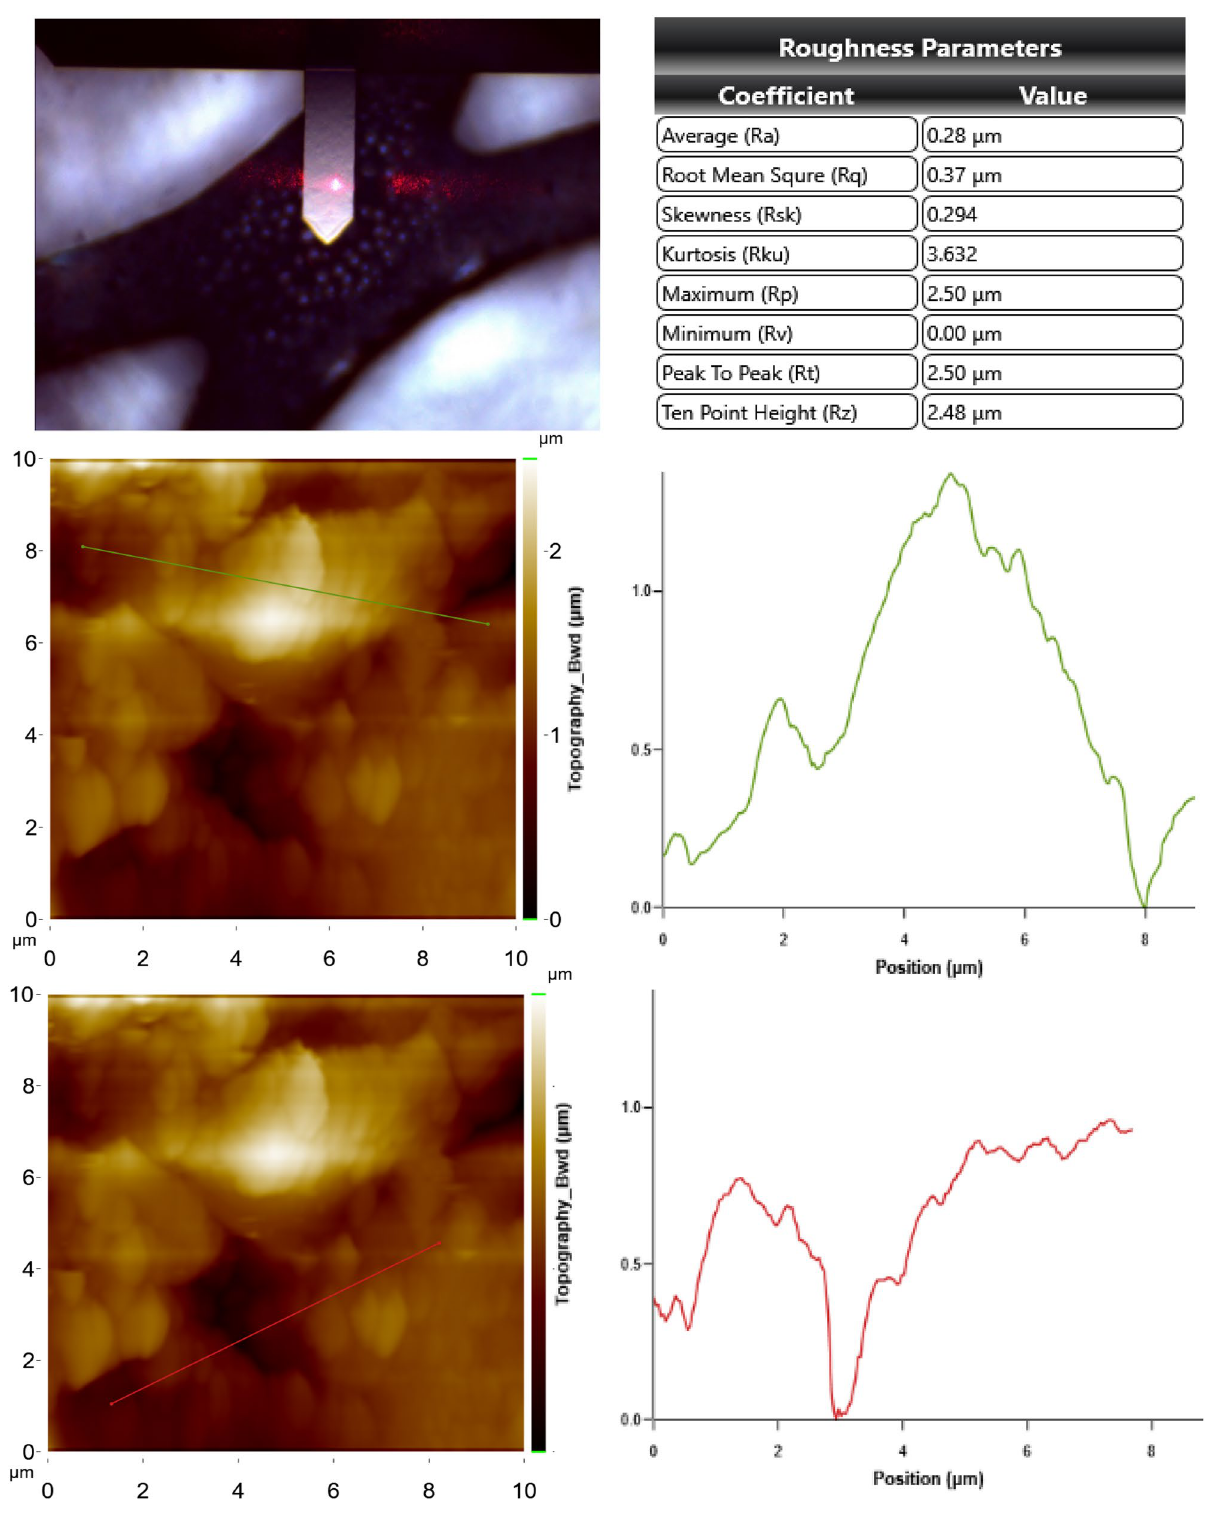
Figure 11. AFM images for upper cross section and bottom cross section of the contaminated